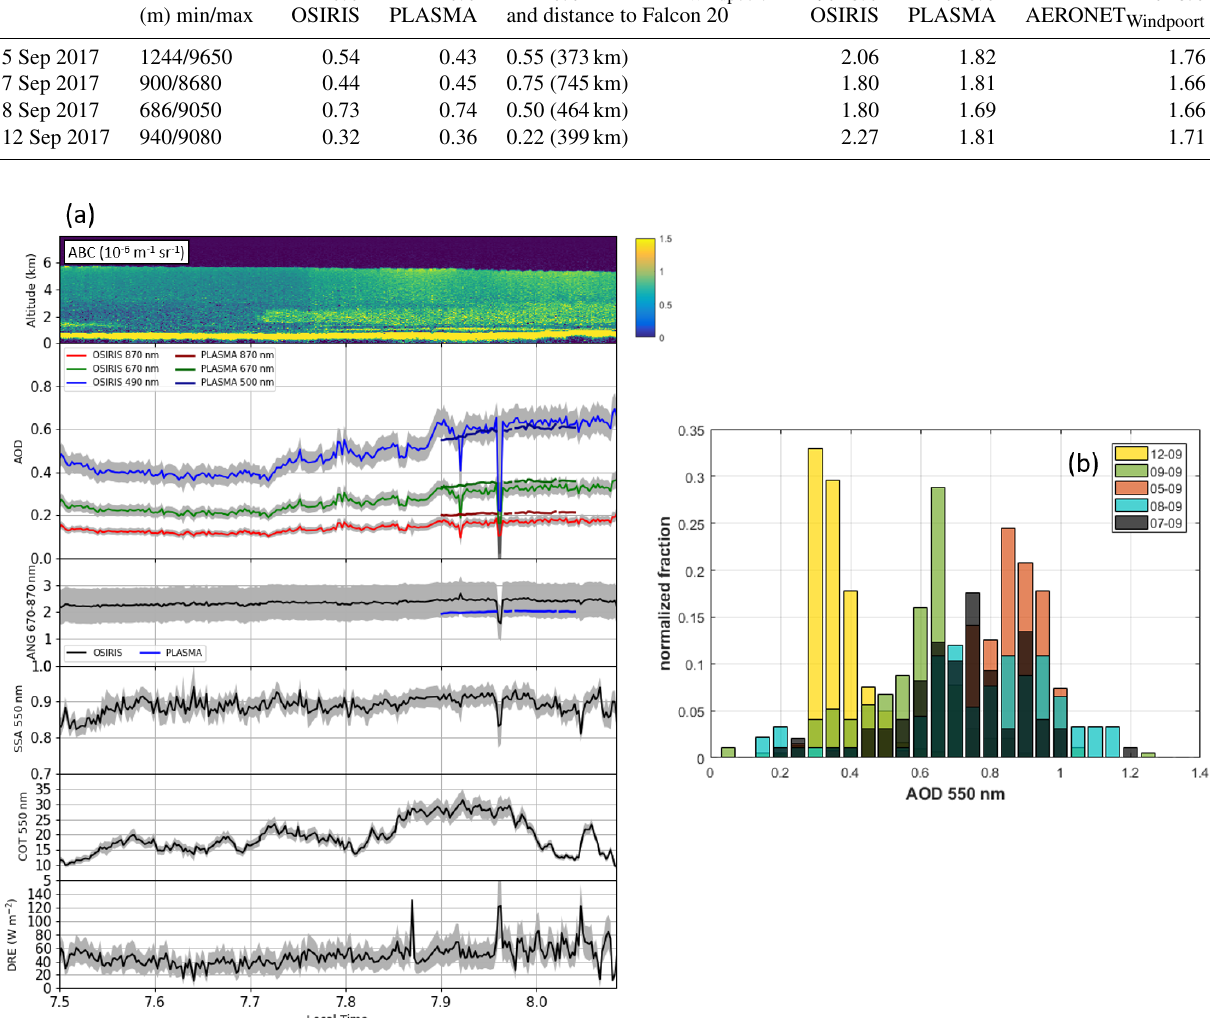
Figure 7. (a) Time series of the ABC profiles measured at 1064nm by the lidar LNG, above-cloud AODs, Ångström exponents (670– 870nm), aerosol SSA, cloud optical depth and direct radiative effect estimated on 12 September 2017, and associated errors. (b) AOD histograms from OSIRIS measurements for the five selected